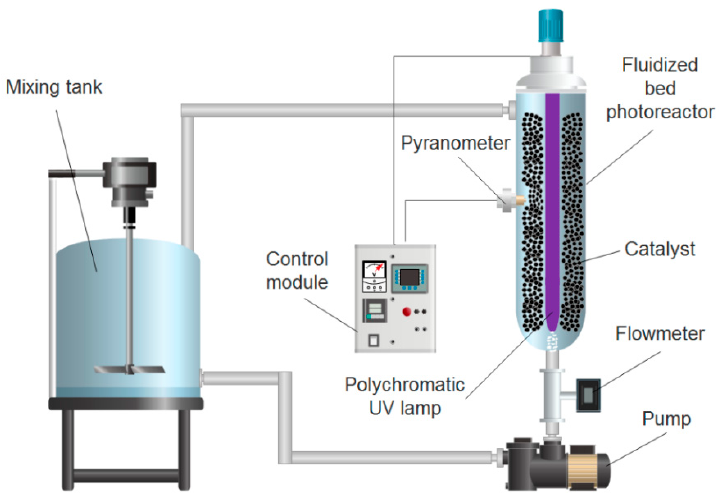
Figure 1. Schematic representation of the FBR-photoreactor at pilot scale used in the photocatalytic and adsorption experiments for aniline and benzothiazole removal from industrial